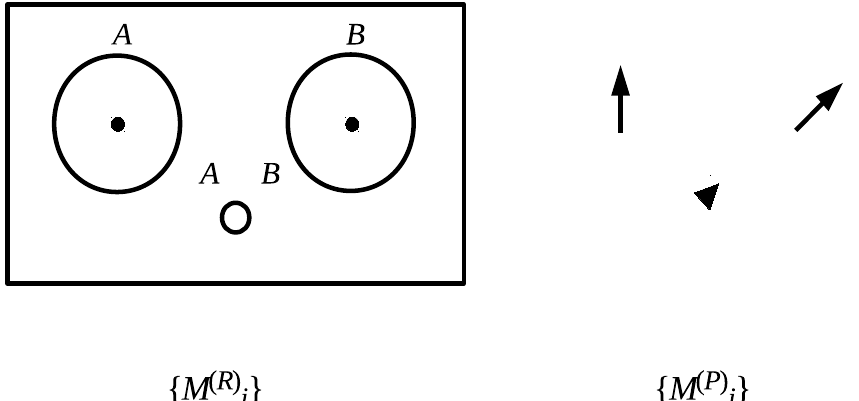
Figure 3. Identifying a system requires many more observables than are required to measure its pointer state, including the positions indicated by control knobs or other “preparation” settings. Adapted from [67] Figure